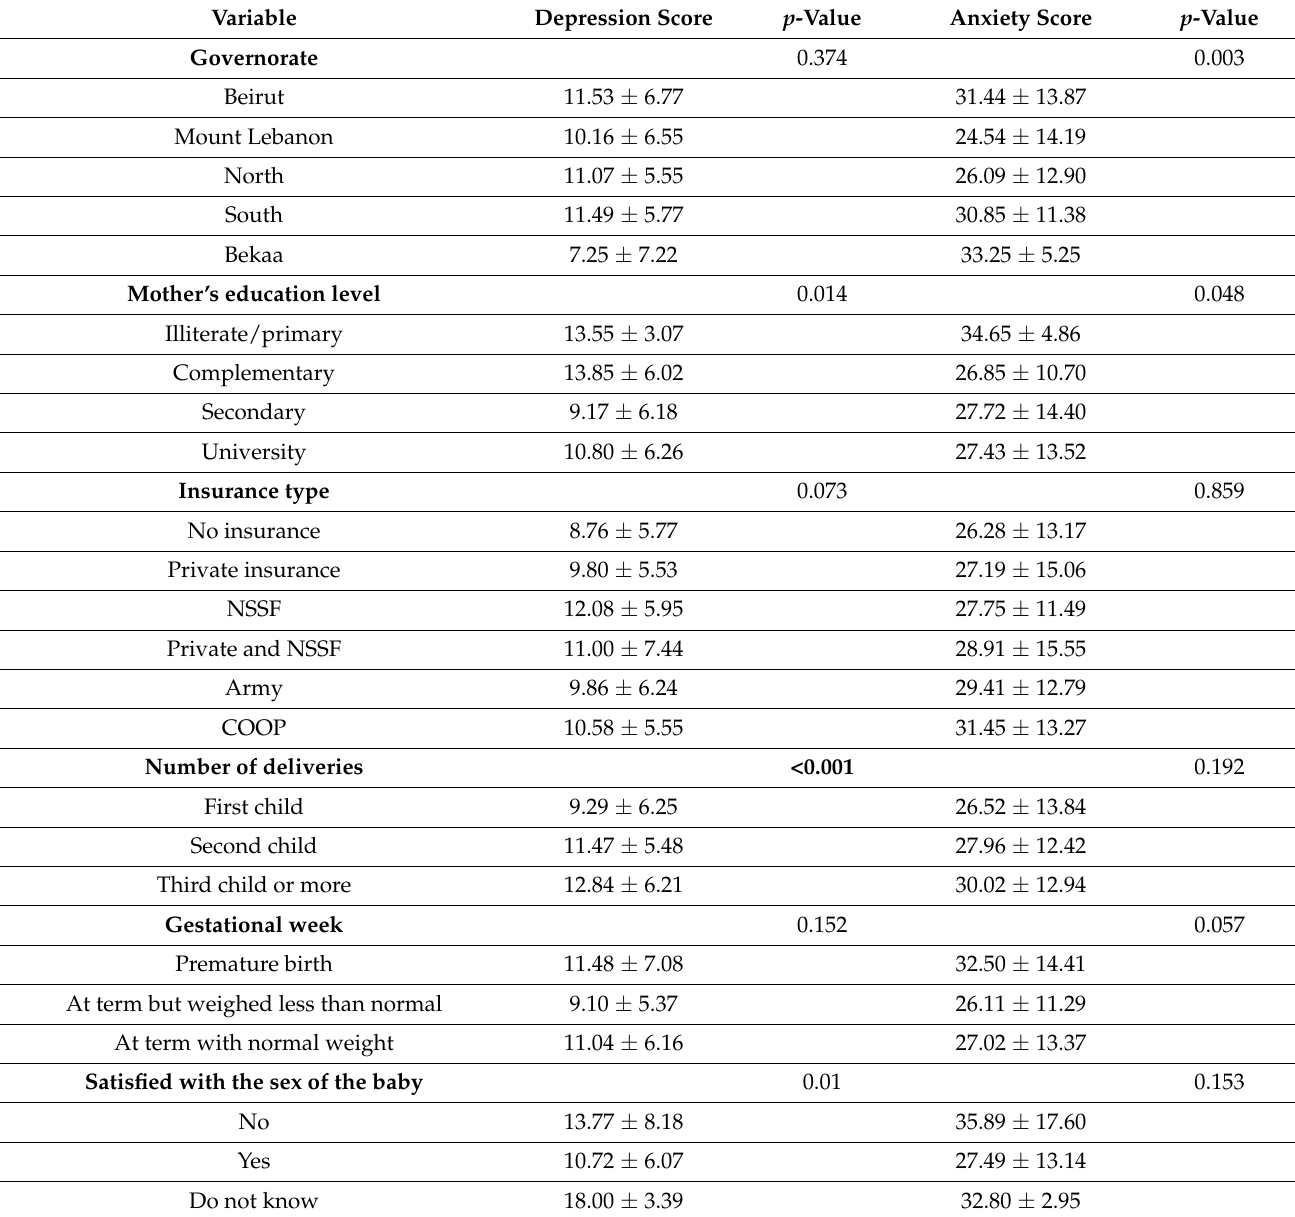
Table 4. Bivariate analysis of categorical variables associated with postpartum depression and anxiety among the